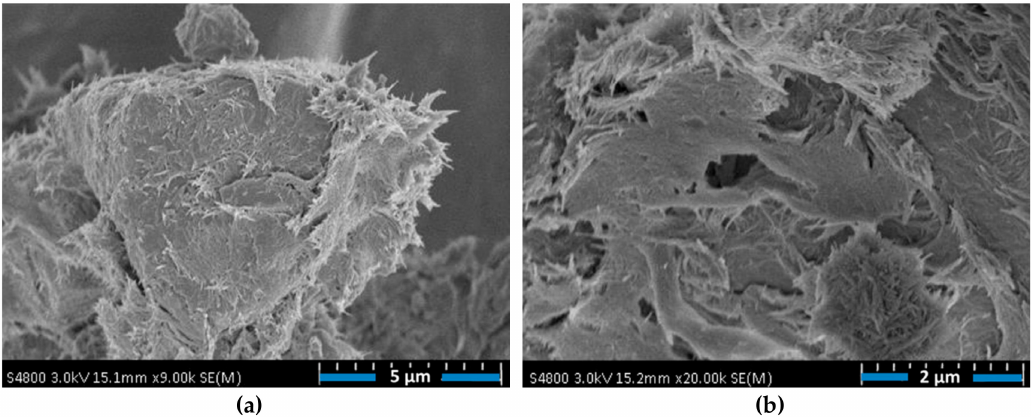
Figure 15. SEM image of the Al 2 O 3 nanofibers diluted in cement pastes at ( a ) 9000 × magnification and ( b ) 20,000 × magnification. Reprinted with permission from [50]. Copyright © 2019, Elsevier